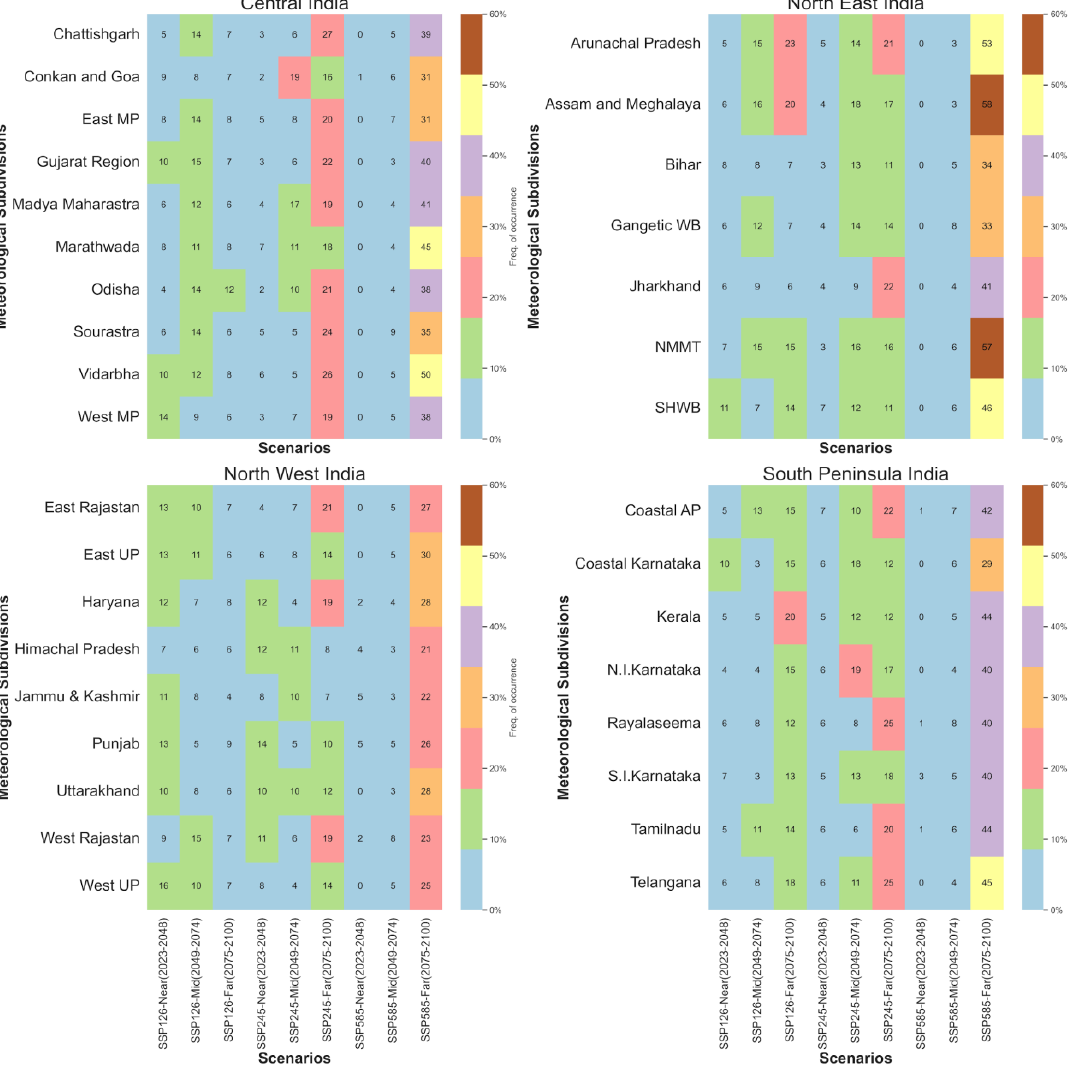
Figure 14. Frequency of occurrence (%) of wet events (12-month SPI ≥ 1.5) at met subdivision level during the southwest monsoon months (June to